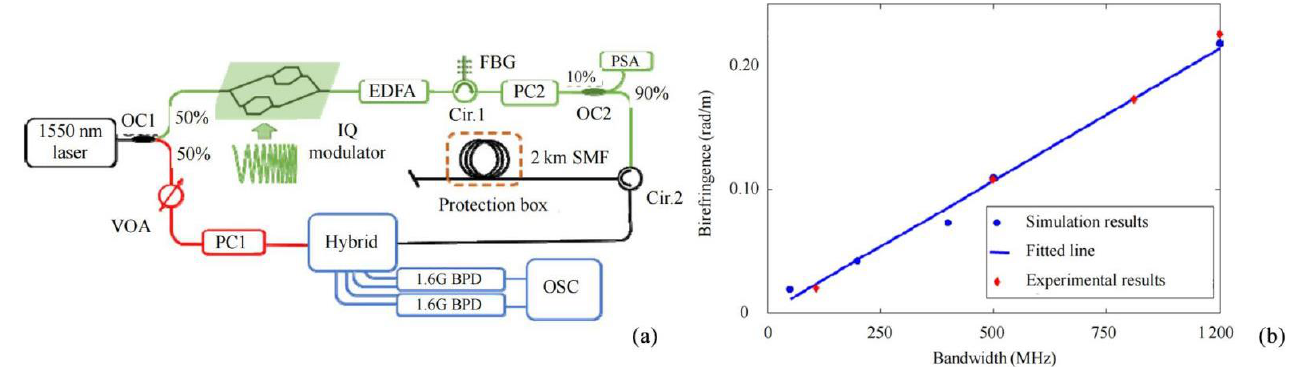
Figure 11. ( a ) Experimental setup. ( b ) Demodulated birefringence of simulation and experiments [51].